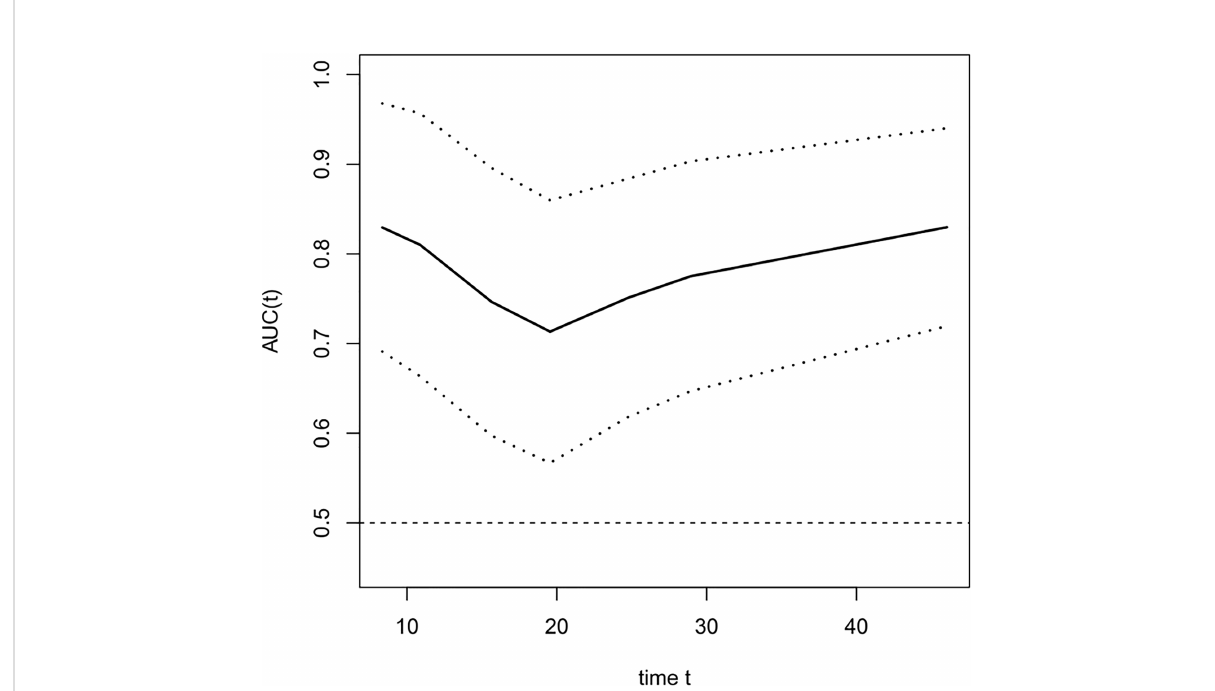
FIGURE 6 The fi tting curve of follow-up time dependent AUC for predicting the overall survival. The solid line is the fi tted line, and the dashed lines on both sides are 95% CI. With the extension of follow-up time, AUC was mostly stable, AUC=0.713~0.830.